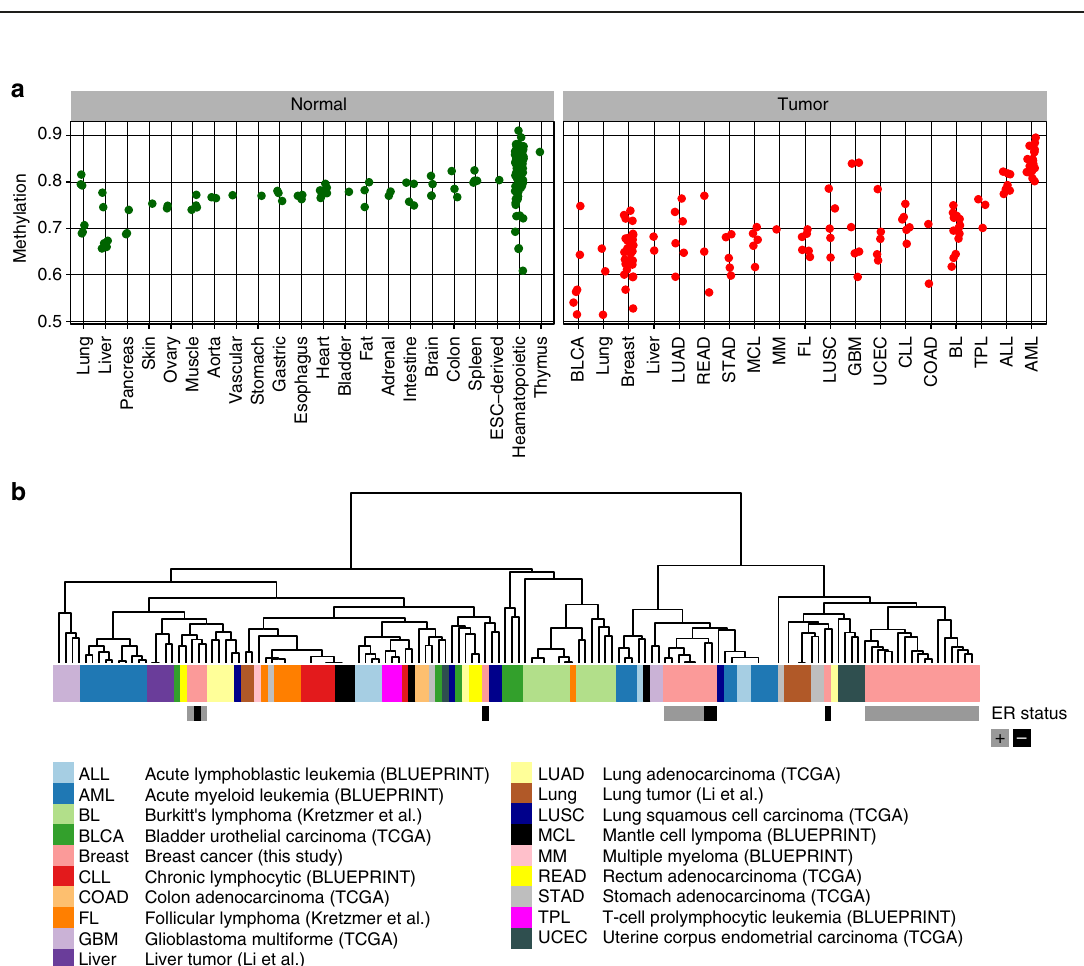
Fig. 4 PMD methylation in normal tissues and tumors of various tissues. a Mean PMD methylation of normal tissues and tumors of various tissue types. Each dot represents one sample. b Hierarchical clustering of tumor samples based on genomic distribution of their PMDs. For breast tumors (this study) the ER status is